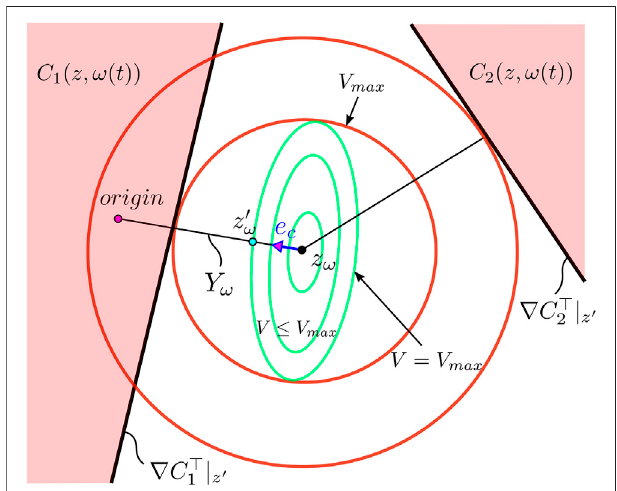
FIGURE 5 | Geometric interpretation of the level set { ζ w | V ≤ V max }. For a constantreference r ,theupdatelaw _ w tothemanipulatedreference w ,places thenewvalue w *attheedgeofthelevelset V (cid:2) V max whiletryingtobeasclose to the actual reference as possible without violating the constrains C i ( z , ω ( t )), which are depicted in